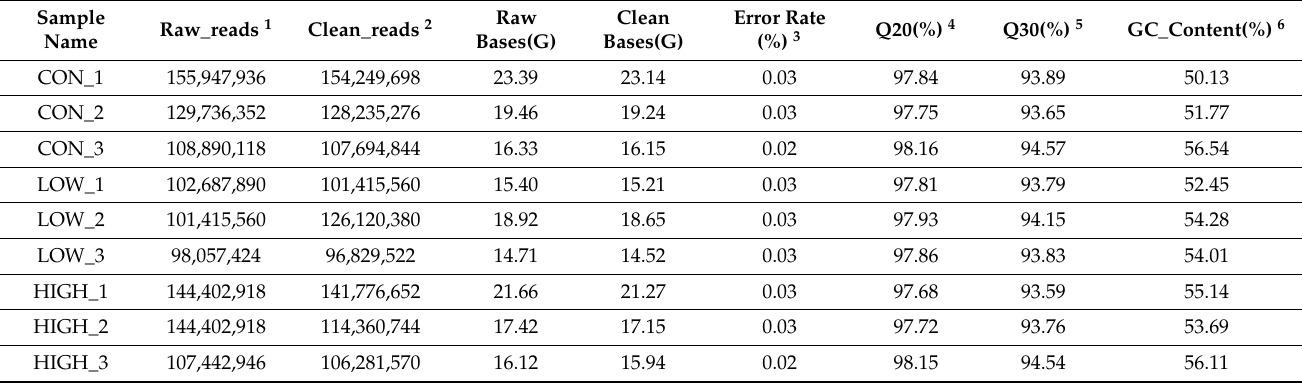
Table 1. The Detailed Information of RNA